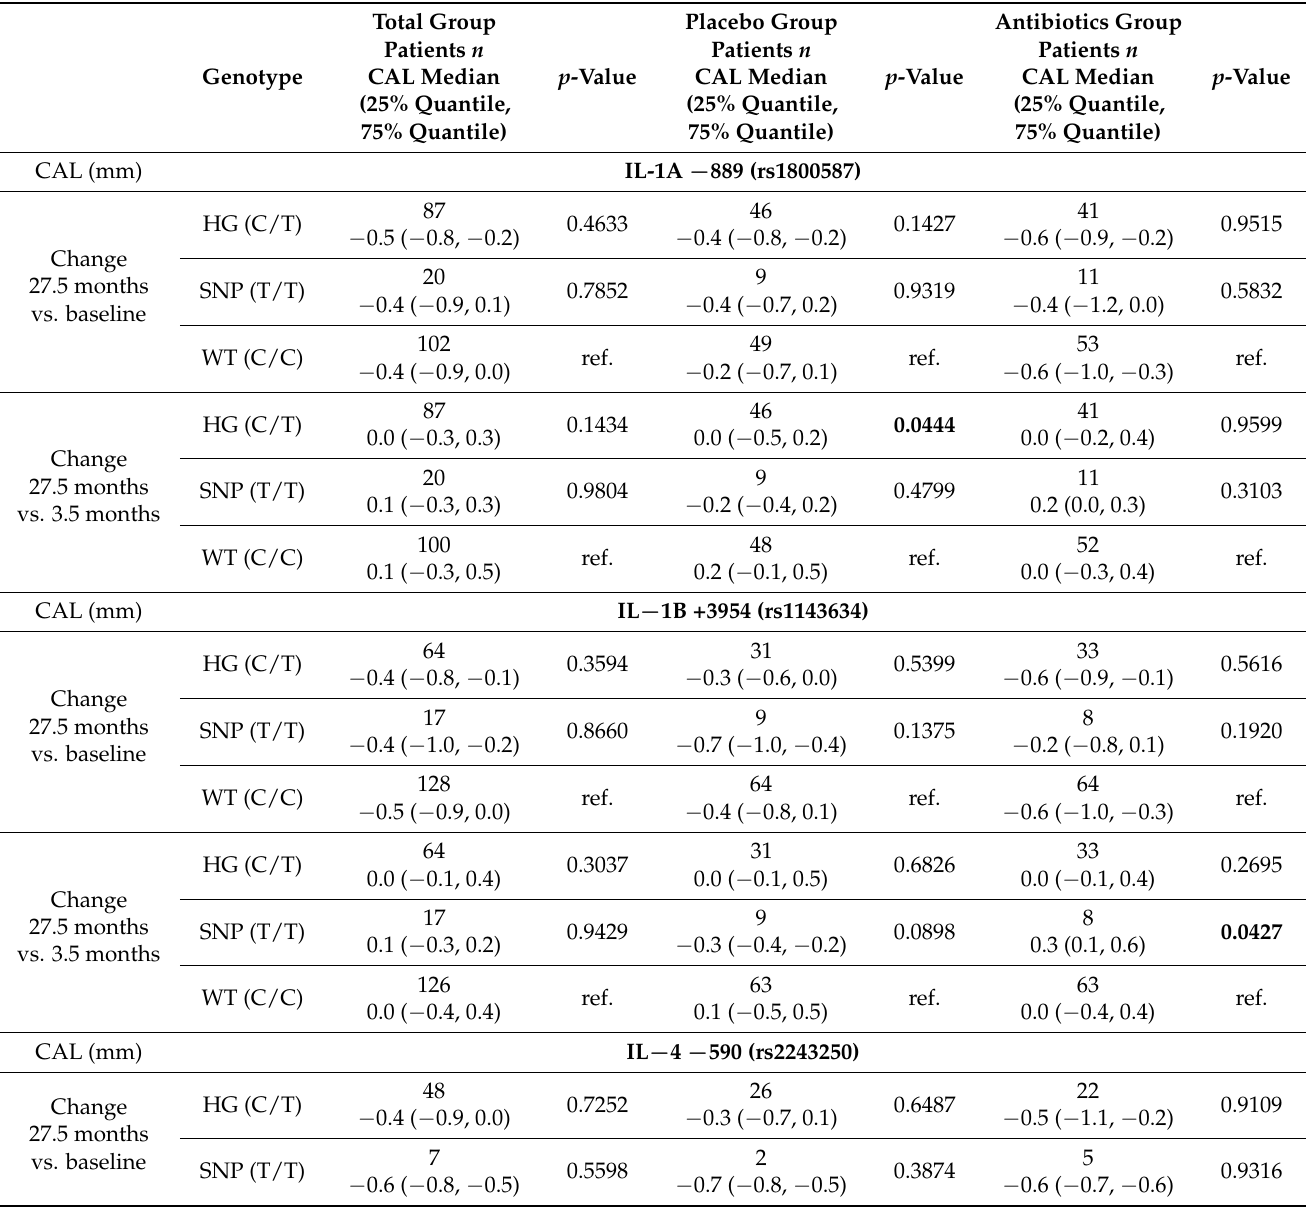
Table 3. Clinical measurements of the change of the